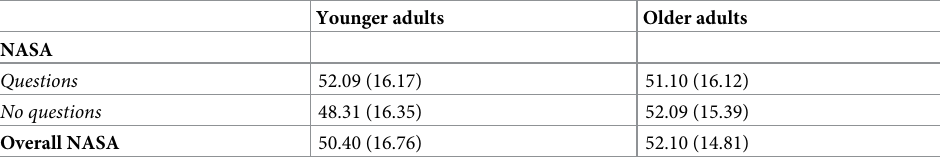
Table 4. Average NASA score (0–100) and standard deviations for each task in each age